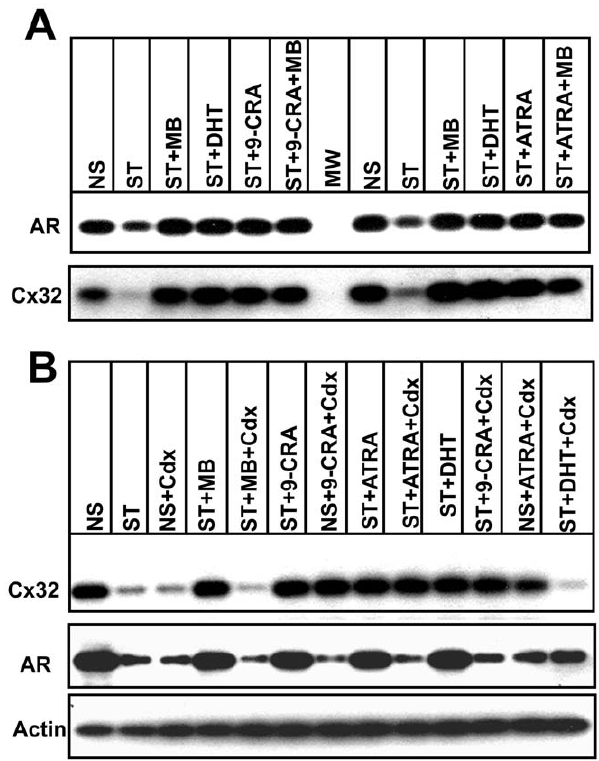
Figure 4. Effect of 9-CRA, ATRA and androgens on the expression level of Cx32 and AR. A . LNCaP-32 cells were grown to 70–80% confluence in 6 cm dishes. Cells were switched to charcoal- stripped, androgen-depleted medium (ST) containing 9-CRA and ATRA (1 m M) and MB (2.5 nM) and DHT (10 nM) for 24 h. Cells in androgen- containing medium (NS) or androgen-depleted medium (ST) were used as controls. Expression level of Cx32 and AR was analyzed by Western blotting. Note that the expression level of both Cx32 and AR decreases upon androgen depletion and the decrease is blocked upon treatment with 9-CRA, ATRA, MB and DHT. B . LNCaP-32 cells, seeded as above, were treated with of 9-CRA and ATRA (1 m M) and MB (2.5 nM) and DHT (10 nM) in the presence and absence of Casodex (10 m M) in normal and androgen-depleted medium. Expression level of Cx32 and AR was examined after Western blotting. Note that in Casodex containing medium, the expression level Cx32 does not decrease in the presence of 9-CRA and ATRA (1 m M) in charcoal-stripped medium despite low level of AR expression. This is not observed with MB and DHT.